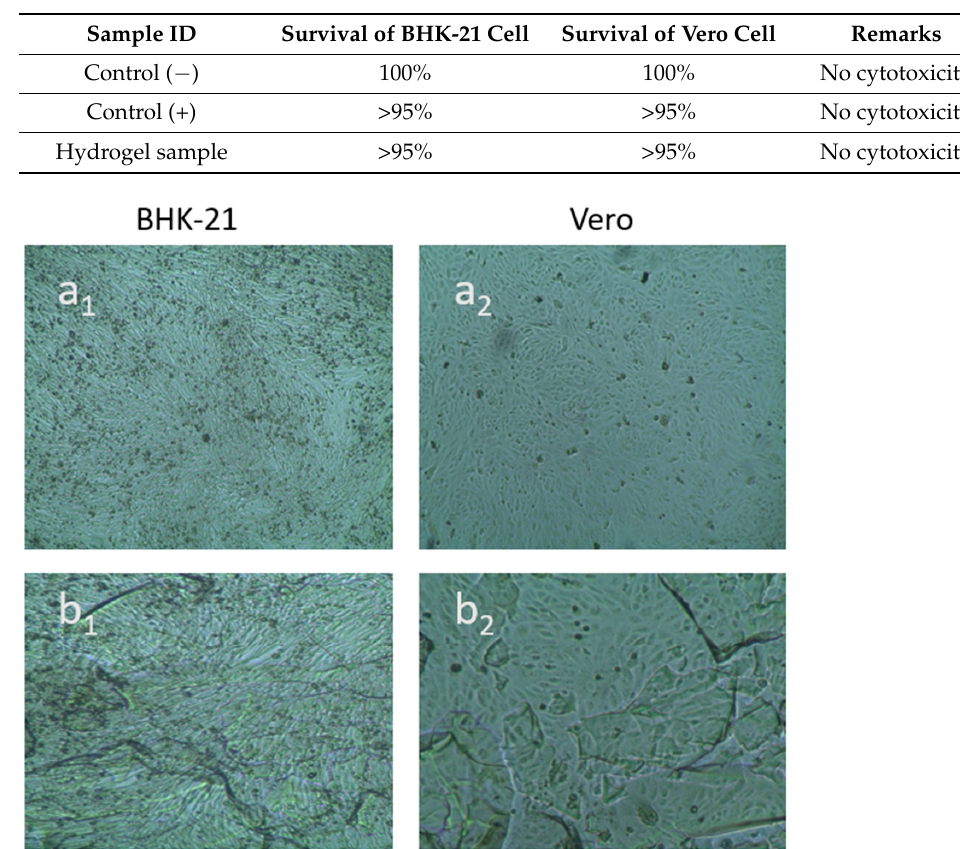
Figure 8. Optical microscopic images of BHK-21 and Vero cell lines treated with semi-IPN hydrogel; ( a1 ) control and ( b1 ) hydrogel after 48 h for BHK-21 cell, ( a2 ) control and ( b2 ) hydrogel after 48 h for Vero cell.